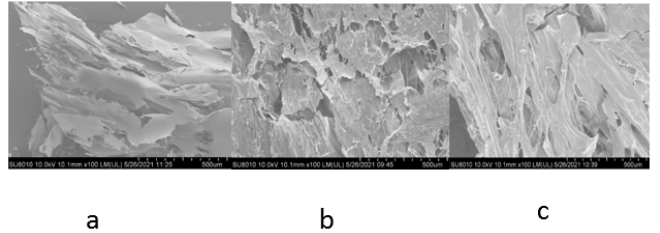
Figure 4. Microstructure of different gels. Note: ( a ) for HG gels; ( b ) for TG gels; ( c ) for MTG gels.